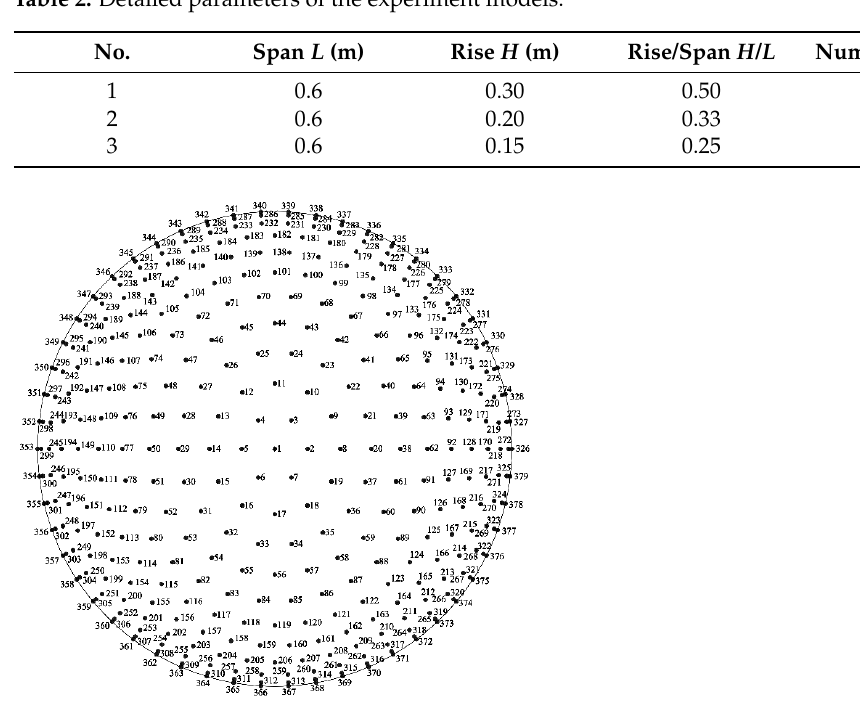
Figure 3. Distribution and numbering of pressure measuring taps.